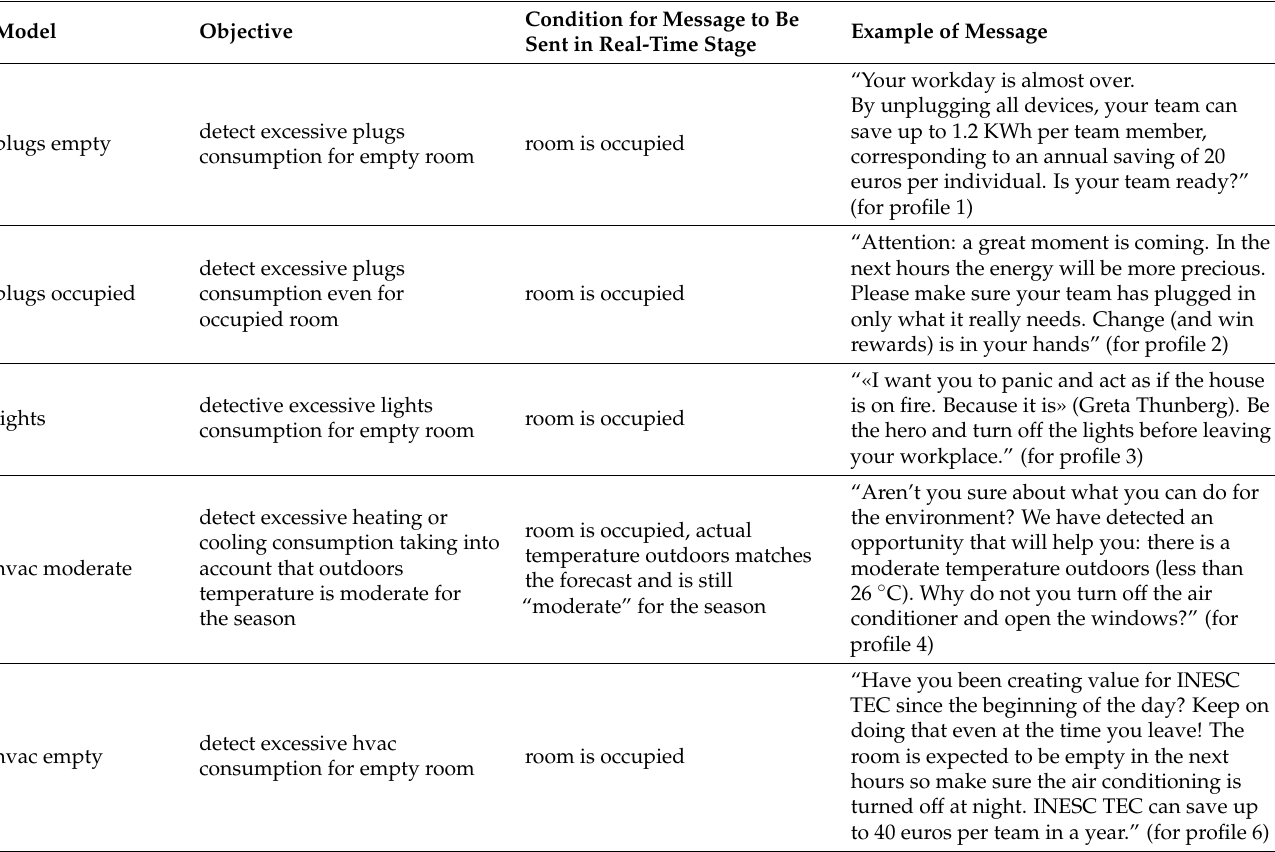
Table 6. Behavior Predictor models